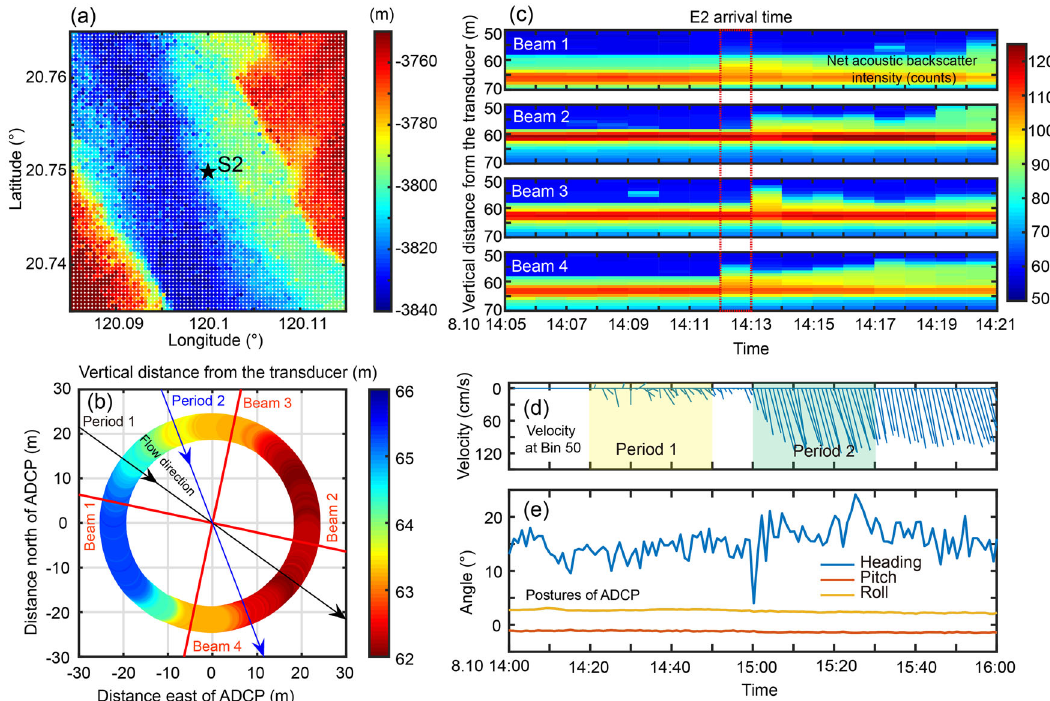
Fig. 6 The arrival process of the turbidity current E2 at the mooring site S2. a Multi-beam bathymetric measurements around the mooring site S2 from Fig. 1b. b The vertical distance from the transducer to the sea fl oor in different directions ( − 180° – 180°) measured by an individual ADCP beam (Beam 3). The center of the ADCP beam ’ s acoustic footprint locates on the right side of the trench fl oor. The red lines are the positions of four beams according to the initial heading of ADCP during E2, which is indicated in ( e ). The black and dark blue lines are the major fl ow direction of Periods 1 and 2 indicated in ( d ). c Net acoustic backscatter intensity (counts) from bin 50 (12 MAB) to 70 of four beam recorded by the downward-looking ADCP. The maximum intensity values indicate the seabed position. The red dashed rectangle indicates the arrival time of the turbidity current E2. d Current velocity vectors at 12 MAB measured by the down-looking ADCP at the initial stage of E2. The light yellow and green rectangles indicate Period 1 and Period 2, respectively. e The postures include the heading, pitch, and roll measured by the down-looking ADCP.